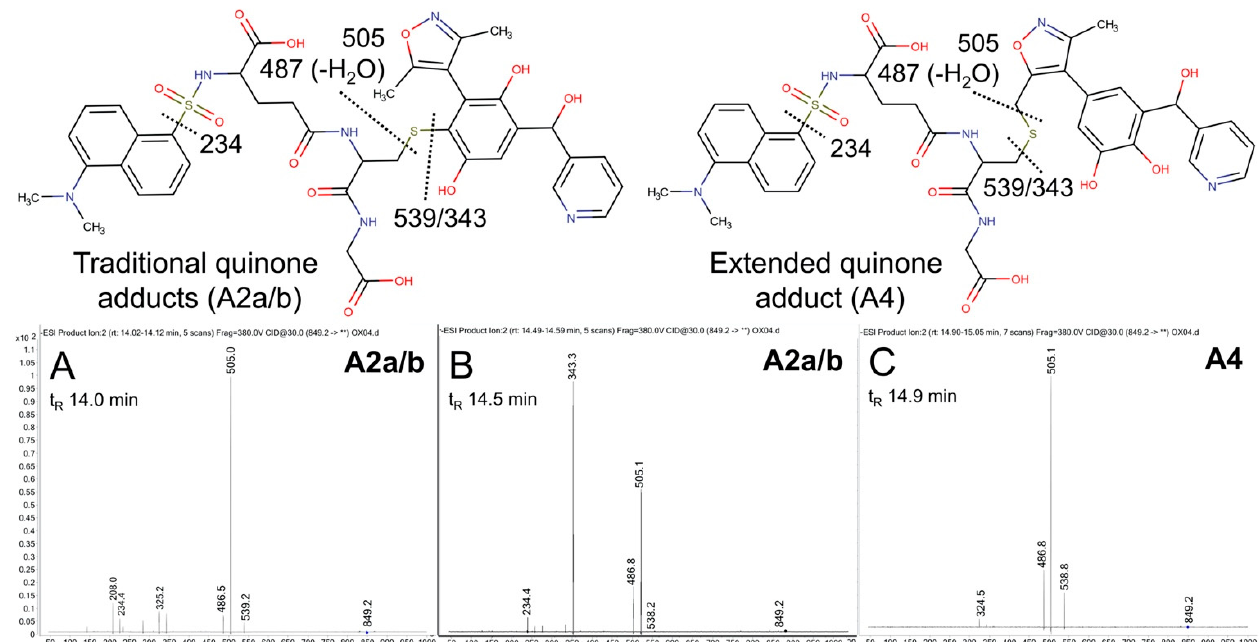
Figure 6. Mass spectrometric product ion spectra for predicted quinone metabolite adducts for OXFBD04. The results show the integrated spectra and product ion fragments for peaks eluting in a 2:1 ratio based on intensity in Figure 4. Characteristic dansyl glutathione fragments m / z 234, 252, 361, 378, 487, 505, and 539 have been reported previously in negative ion mode by Gan and colleagues [54,55]. The site of hydroxylation did not impact the observed fragment patterns. Assignments for the respective fragments are indicated in the accompanying molecular structures for the corresponding adducts. Peak assignments for adducts (Figure 3) are discussed in detail under Results. ( A , B ) shows spectra for the probable pair of adduct isomers (A2a/b) from a traditional quinone (Q2), while ( C ) shows that for the lone, lower intensity peak for A4 arising from the extended quinone methide (EQ).